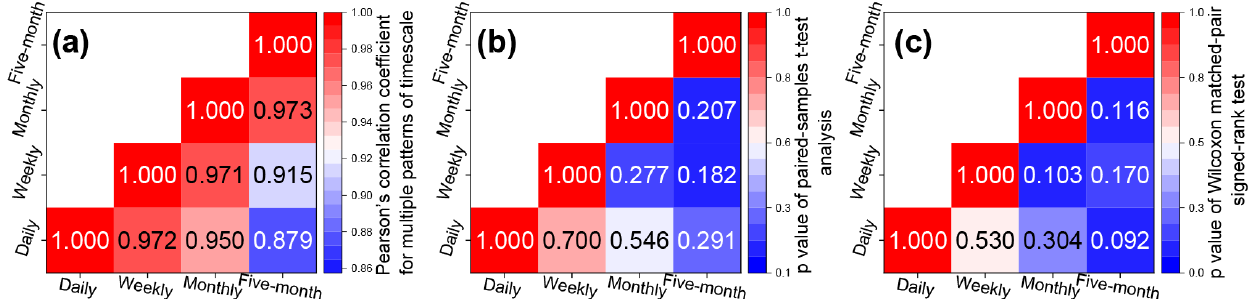
Figure 8. The statistical analysis results of RIR values (from Table S6) at multiple patterns of timescale: (a) Pearson’s r correlation analysis (all the results have passed statistical significance, assumed to be p< 0 . 01); (b) paired-samples t -test analysis ( ∗ p values refer to differences with a statistical significance assumed to be p< 0 . 05); (c) Wilcoxon matched-pairs signed-rank test ( ∗ p values refer to differences with a statistical significance, assumed to be p< 0 . 05).